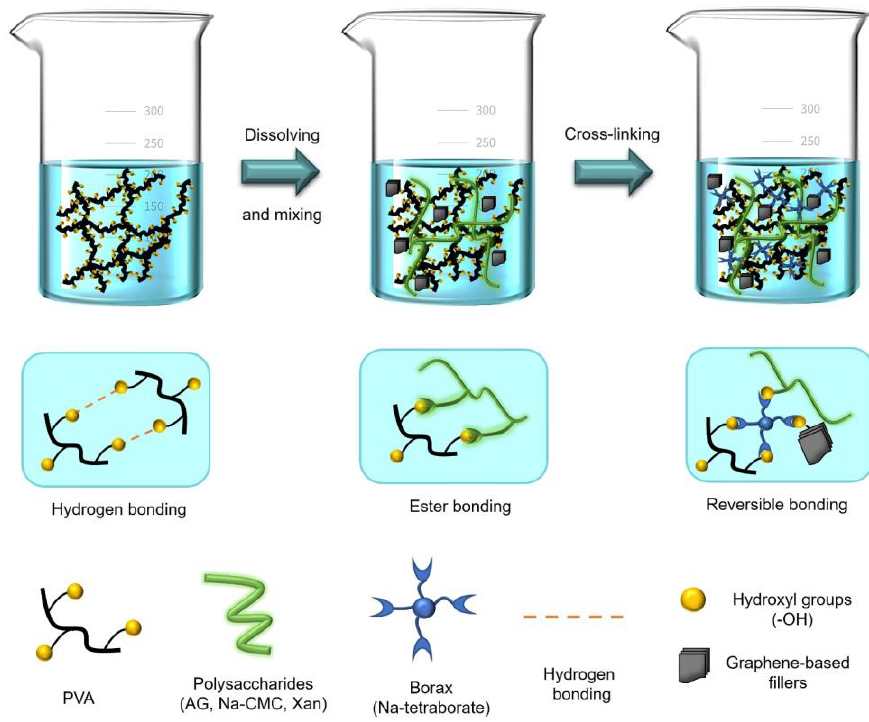
Figure 1. Schematic illustration of the synthesis process of conductive nanocomposite hydrogels.